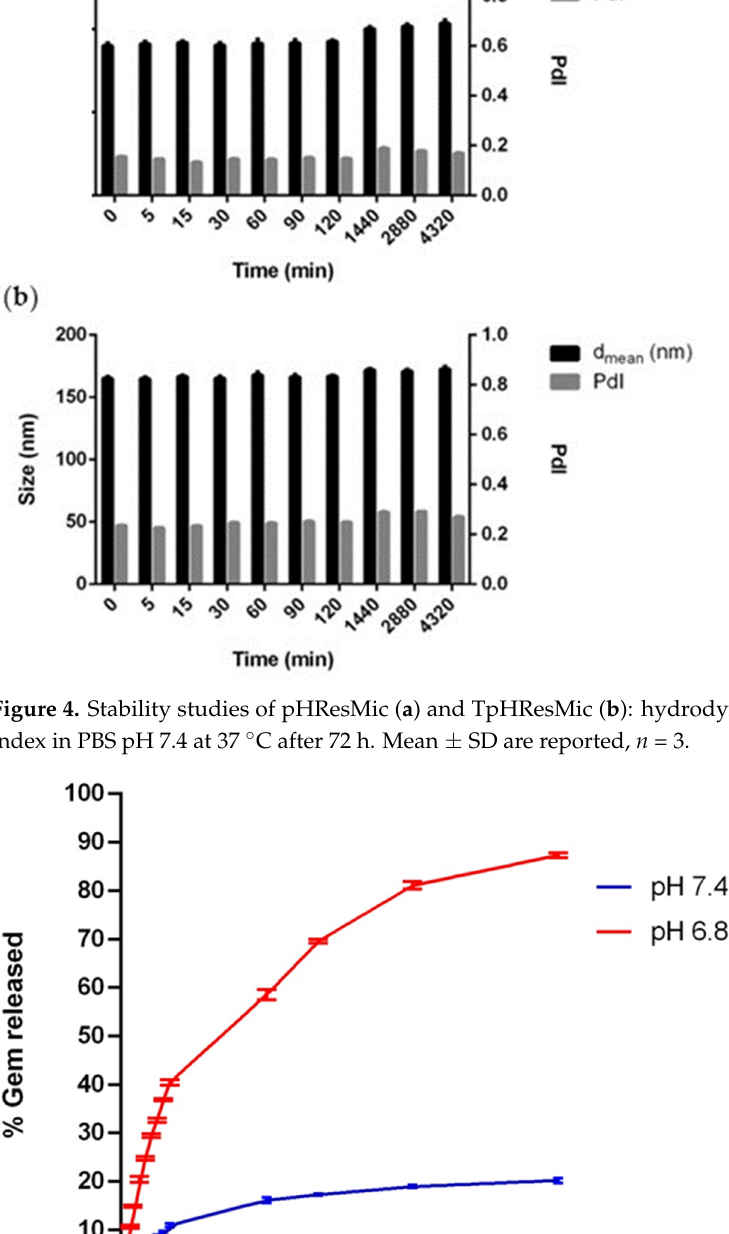
and 7.4). Results are reported as mean ± SD, n =